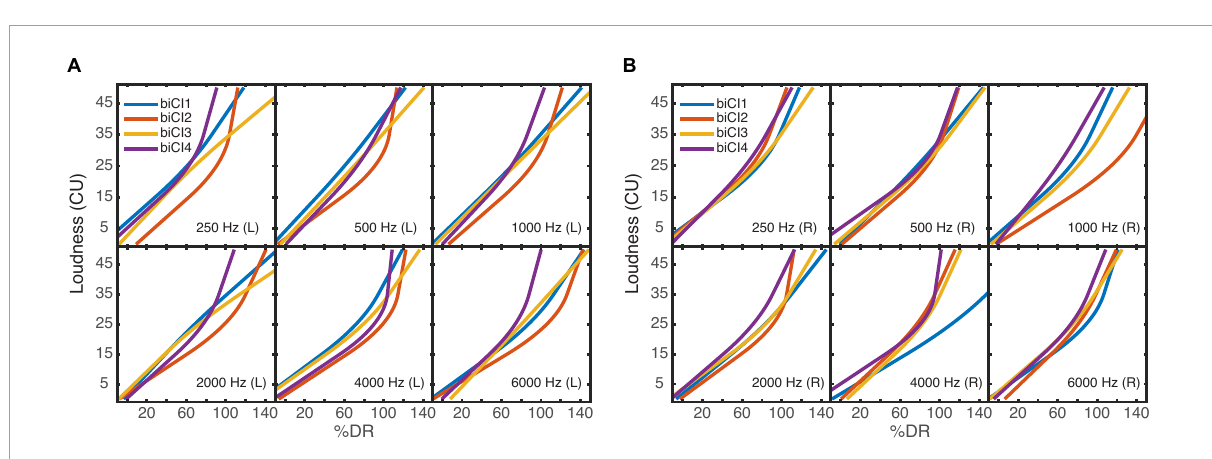
FIGURE4 Averaged loudness functions of the six narrowband noises for each of the four biCI listeners. (A) left ear, (B) right ear. The stimulations of 0% DR and 100% DR corresponded to the listeners’ T- and M-level thresholds. As in Figure 3 the loudness functions can have a different range across listeners and electrodes due to individual